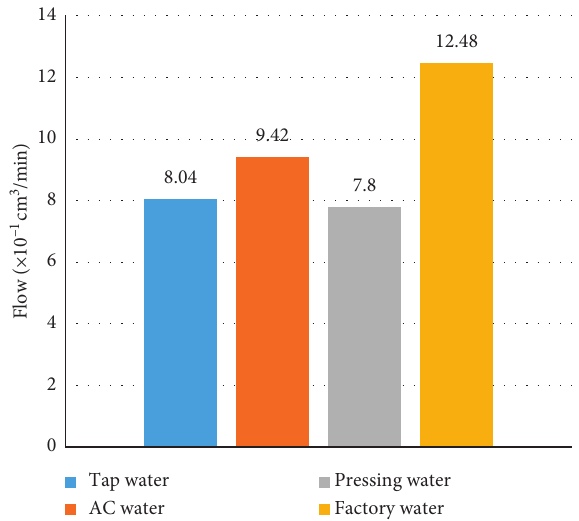
Figure 6: Flow rates of the different types of